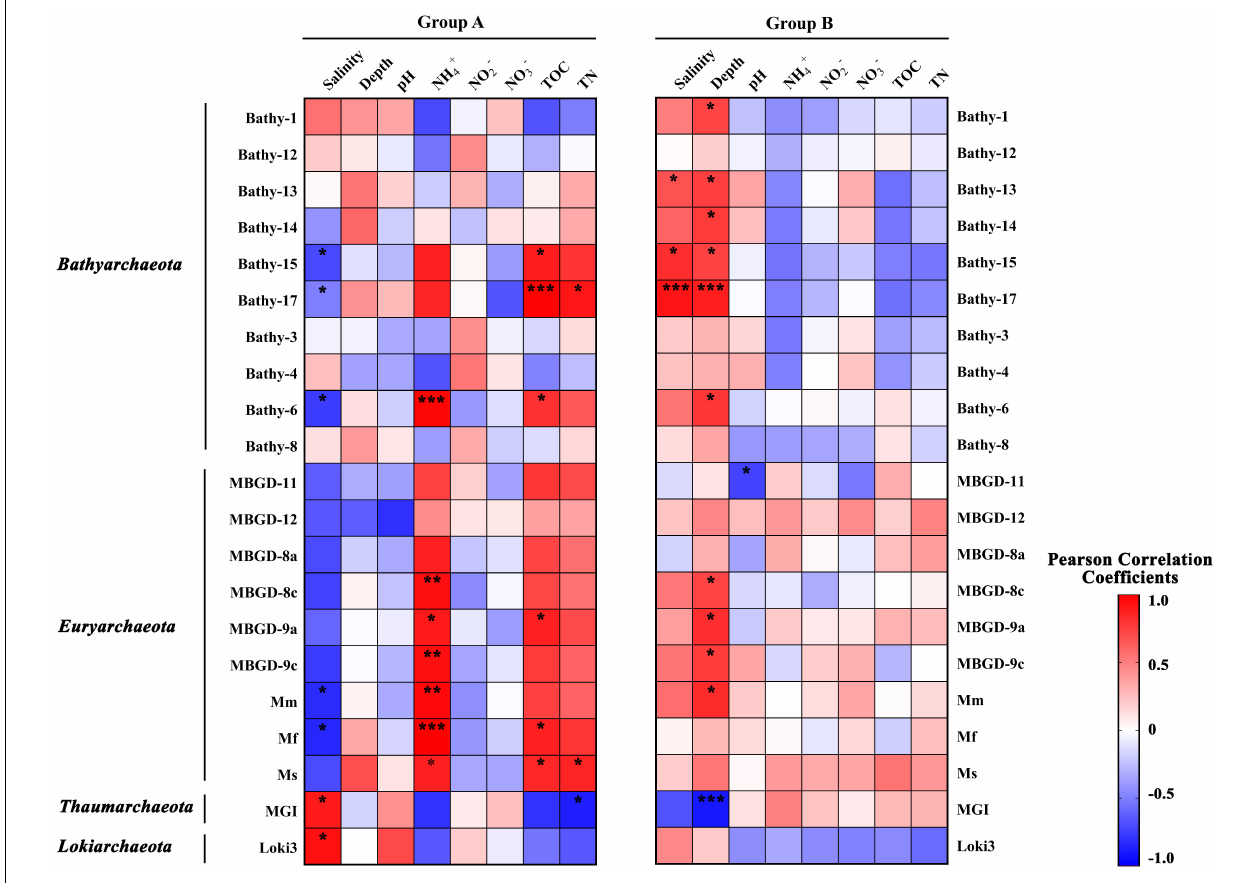
FIGURE 5 | The Pearson correlation coefficients between physicochemical parameters and major archaeal subgroups in Group A (relatively low salinity) and Group B (relatively high salinity). Red squares, positive correlations; blue squares, negative correlations. *, **, and *** represent the significance at 0.05, 0.01, and 0.001 level, respectively. Mm, Mf, and Ms stand for Methanomicrobiales , Methanofastidiosales, and Methanosarcinales ,